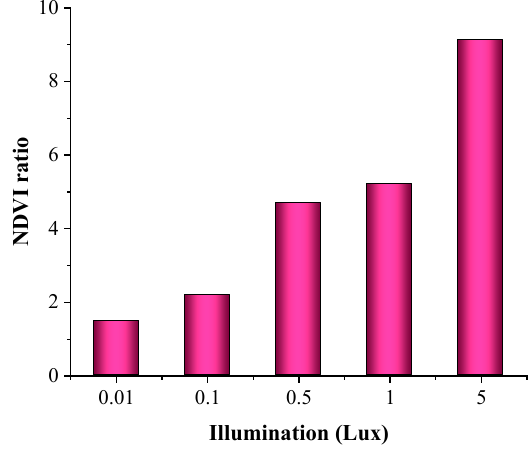
Figure 6. Histogram of the NDVI with different illuminations.